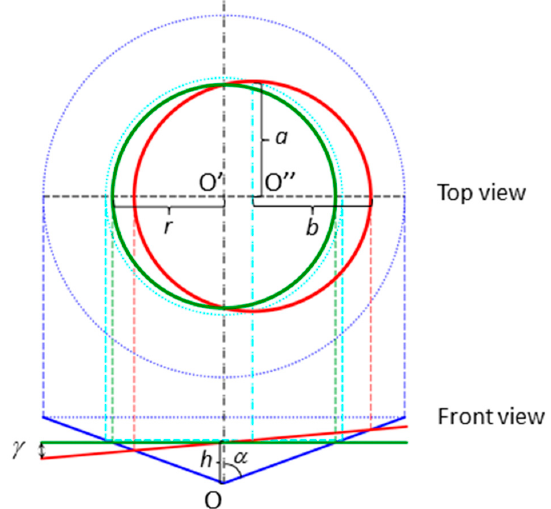
Figure 7. Front view: Graphical representation of a right circular conical indenter penetrating a normal (green solid line) and an oblique surface with γ = 5° (red solid line). Top view (rotated 90°): corresponding projected contact areas with the same color code. Cyan dotted lines represent the circular straight cross-section of the cone passing through the center O ″ of the oblique red ellipse. Their intersection provides the semi-axis a . All vertical dotted lines are imaginary projection lines.